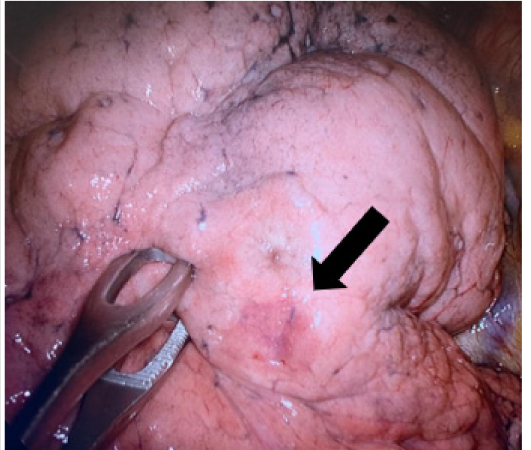
Figure 4. A case of hydrogel plug dislodgment. The arrow indicates the subpleural suffusion nearby the percutaneous lung puncture. Arrow: outlines the subpleural